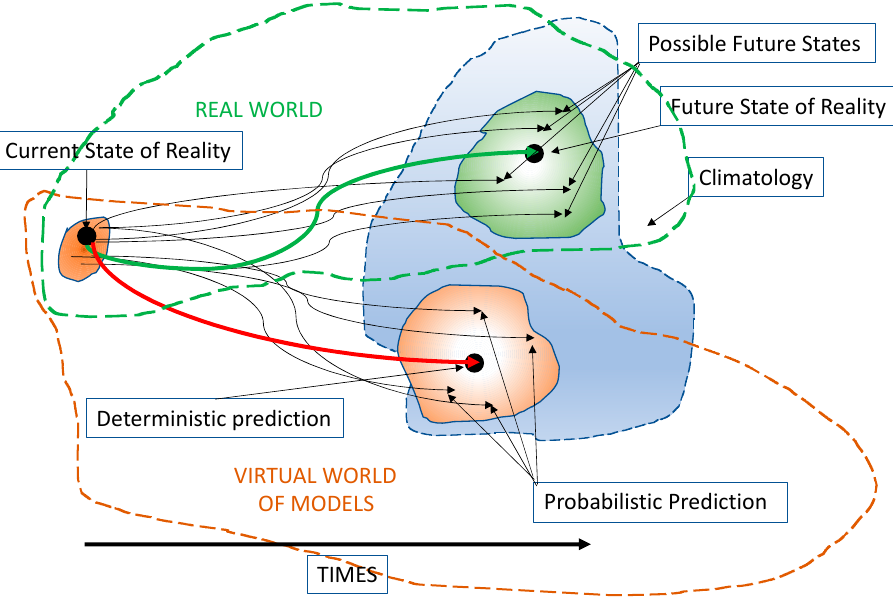
Figure 6. Uncertainty in the evolution of a chaotic physical system (Real World) and its modeled representation (Virtual World of Models). In green the evolution from the current state to the actual future value (solid line) and to possible alternative future states (green zone). In red, the evolution of the current state to the expected value of the future state (solid line) while the evolution of the model’s predictions from the present to the future (orange zones), is not necessarily coinciding with the real future states (redrawn from [4]).